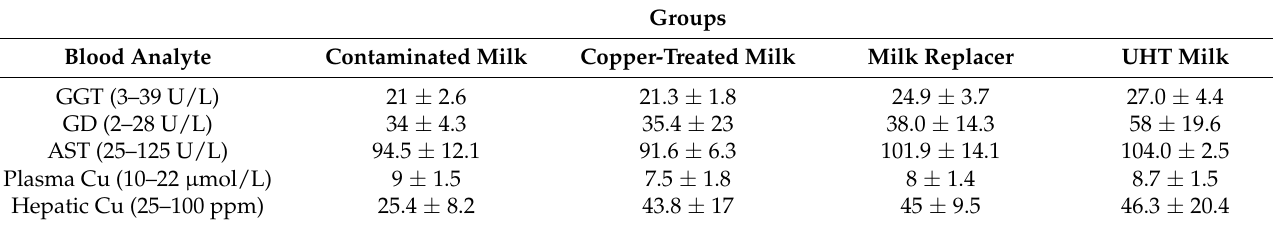
Table 3. Mean plasma copper (Cu) concentrations, plasma activity of liver enzymes glutamate dehydrogenase (GD), gamma- glutamyl transferase (GGT), and aspartate aminotransferase (AST) and hepatic copper concentrations, per experimental group during the experimental period (mean ± standard deviation of 9 monthly samples). The reference intervals are shown in